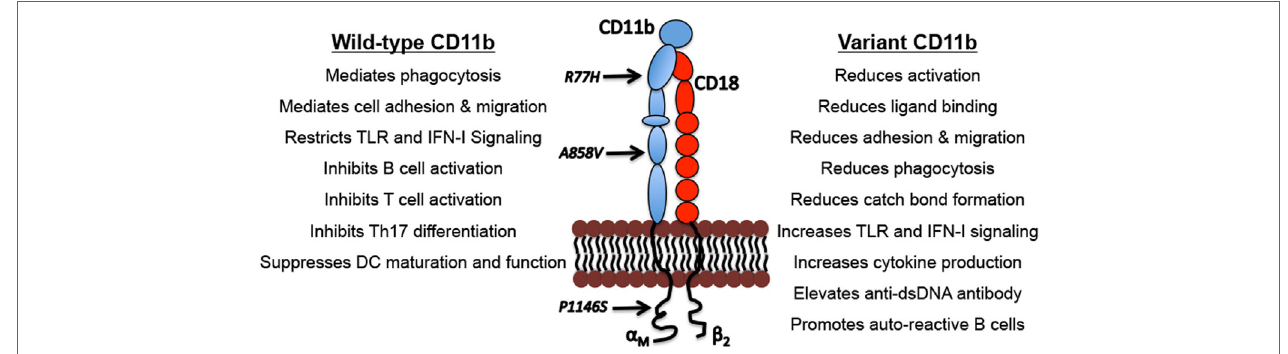
FigURe 1 | Biological functions of CD11b and the functional outcomes of CD11b variants. Indicated are examples of well described physiological functions of integrin CD11b and the functional consequences of the genetic variations that can drive lupus nephritis pathogenesis.